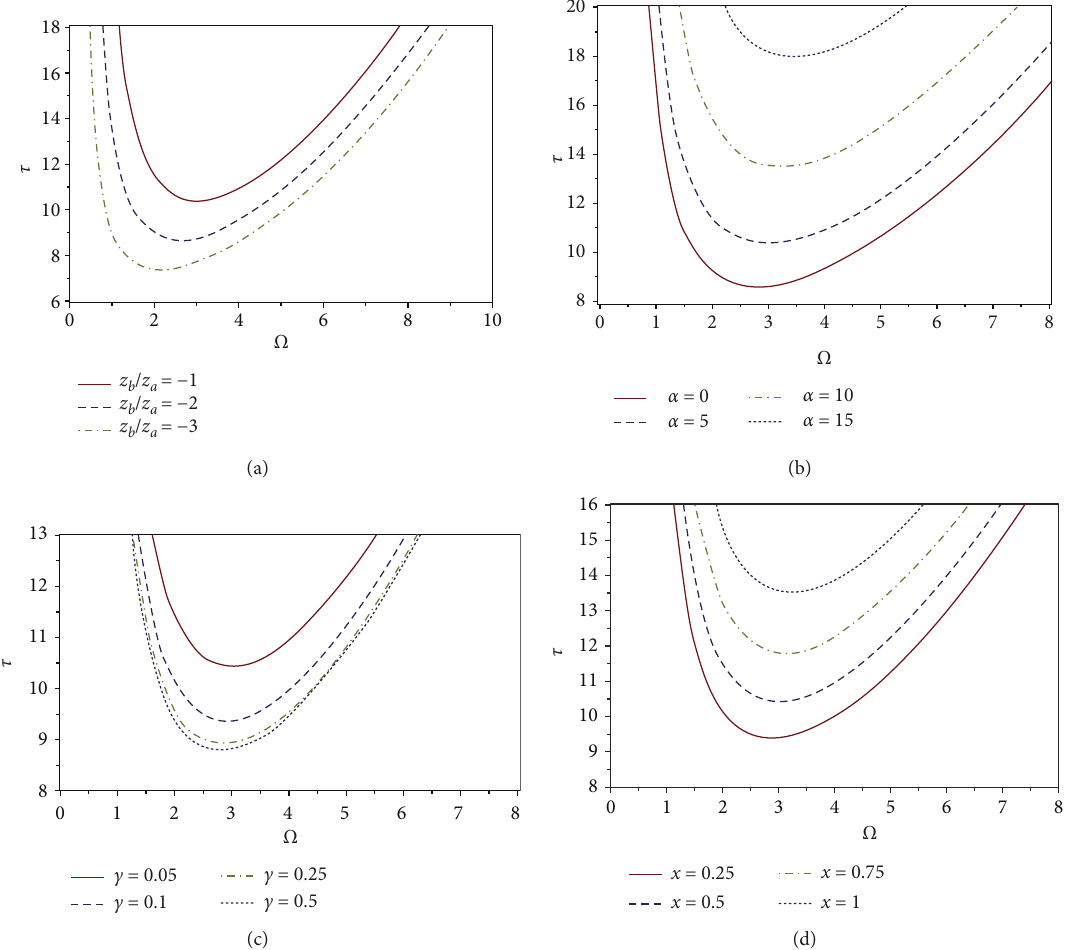
Figure 5: (a) Optimal time of separation predicted for a resolution with a value of two in a diverging pore with orthogonal applied electrical fi eld ( Ω = Ω ): Pe = 2 , γ = 0 05 , ̂ x = 0 5 , α = 5 , μ Α for a resolution with a value of two in a diverging pore with orthogonal applied electrical fi eld ( Ω Α = Ω ): Pe = 2 , γ = 0 05 , ̂ x = 0 5 , μ / z = 2 , and di ff erent angles of divergence, α . (c) Optimal time of separation predicted for a resolution with a value of two in a diverging z B A pore with orthogonal applied electrical fi eld ( Ω Α = Ω ): Pe = 2 , γ = 0 05 , ̂ x = 0 5 , μ (d) Optimal time of separation predicted for a resolution with a value of two in a diverging pore with orthogonal applied electrical fi eld ( Ω Α = Ω ): Pe = 2 , γ = 0 05 , ̂ x = 0 5 , μ